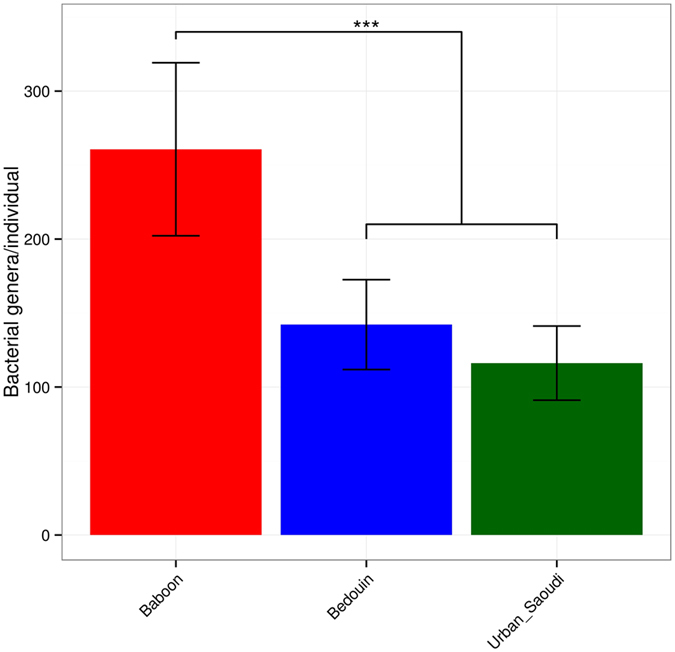
Diminished diversity in human and baboon gut microbiomes across populations.Mean numbers of observed bacterial genera per individual in baboons and in human populations at a sequencing depth of 20,000 reads. Error bars correspond to 95% CIs, and asterisks denote significant differences at p < 0.001.